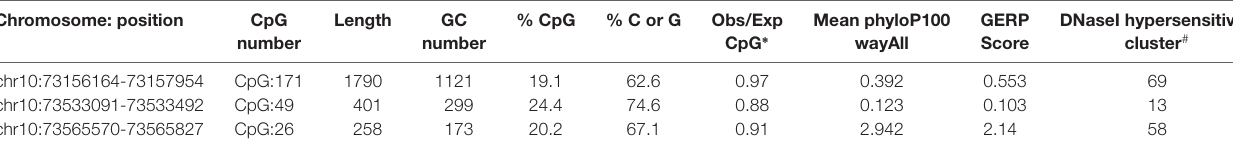
TABLE 2 | Characteristic and evidence for conservation of intragenic Cadherin 23 ( CDH23 ) CpG island in the human (GRCh37/hg19) and other species genomes, generated by UCSC genome Browser. Chromosome: position CpG Length GC % CpG % C or G Obs/Exp Mean phyloP100 GERP DNaseI hypersensitivity number number CpG ∗ wayAll Score cluster #